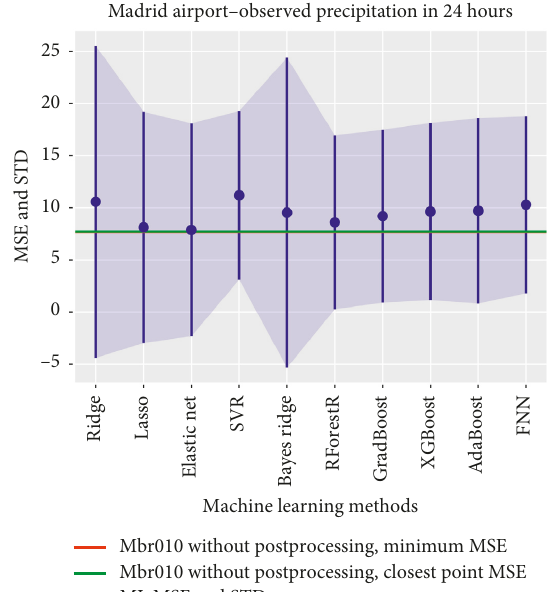
Figure 18: Precipitation in 24hours, calibration plot for Madrid airport. Horizontal axis, from left to right: ridge, lasso, elastic net, singular vector regression, Bayesian ridge, random forest re- gression, gradient boosting regression, XGBoost regression, Ada- Boost regression, and feedforward neural network.